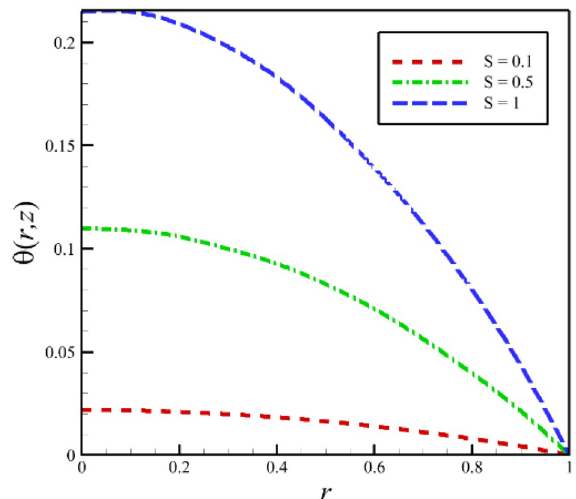
Fig. 12 The influence of variation